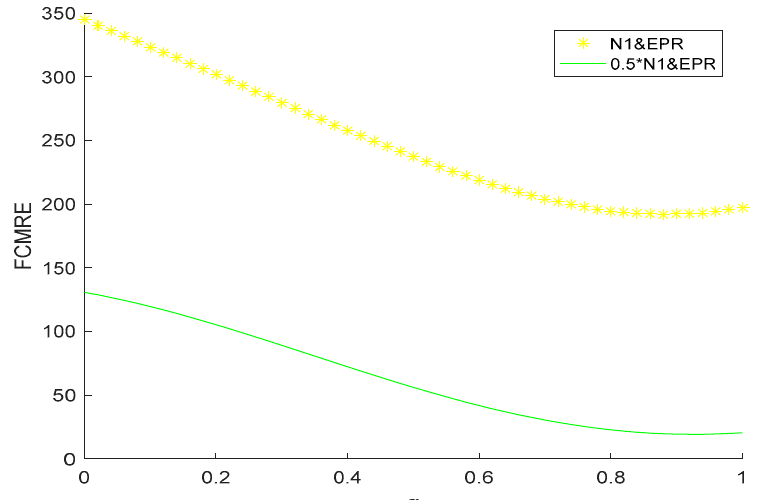
Figure 3. The fractional cumulative residual MRE of N1, 0.5 N1, and EPR time series.